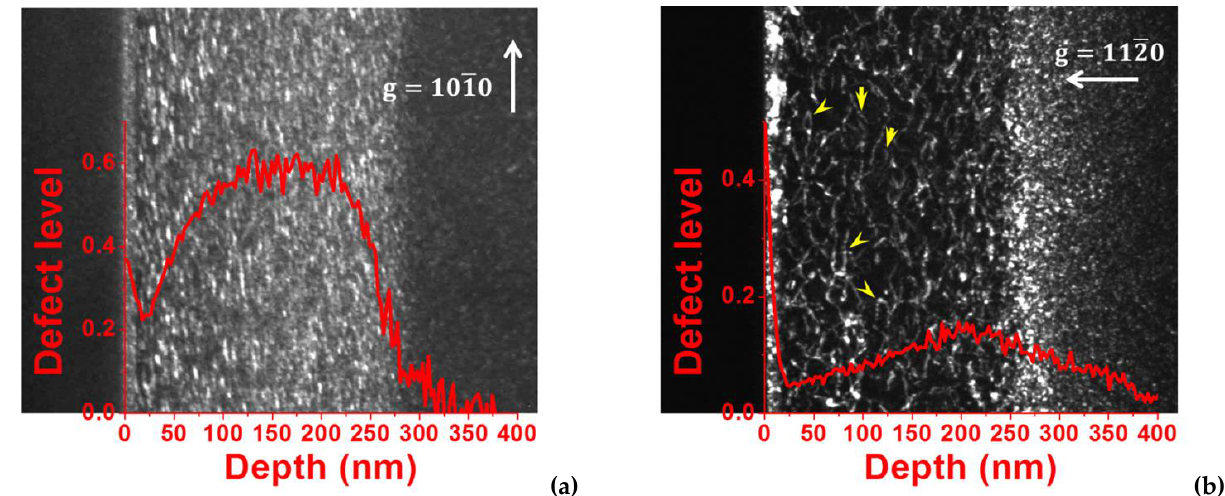
Figure 3. Cross-sectional transmission electron microscopy (TEM) images of c-plane GaN ( a ) and a-plane GaN ( b ) implanted with 300 keV Ar using a fluence of 8 × 10 15 at/cm 2 . The defect profiles derived using RBS/C were superimposed onto the TEM images. In ( b ), a large density of dislocation loops can be observed, some of which are marked by yellow arrows. Adapted with permission from Ref. [44].